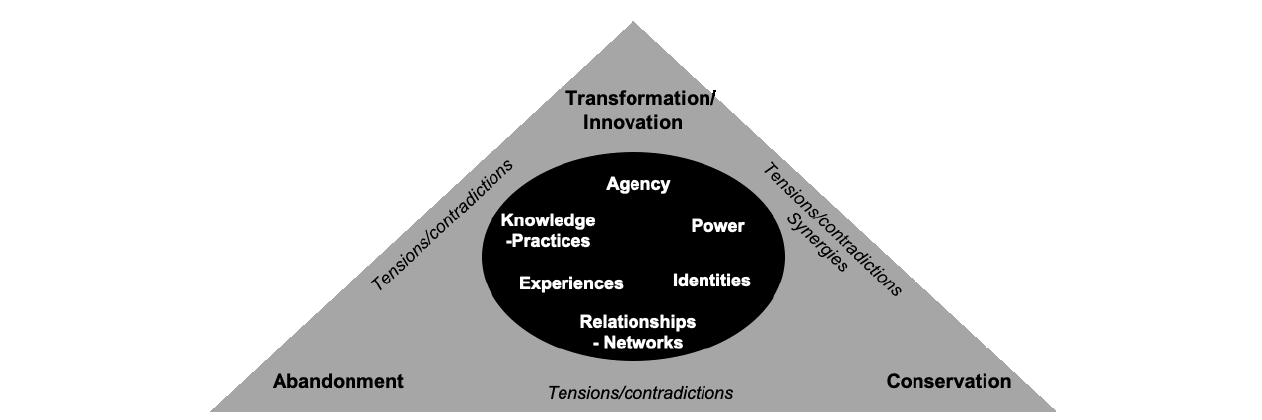
Fig. 1 . Triangle used by women during the workshops to identify their contributions to abandonment, conservation, and